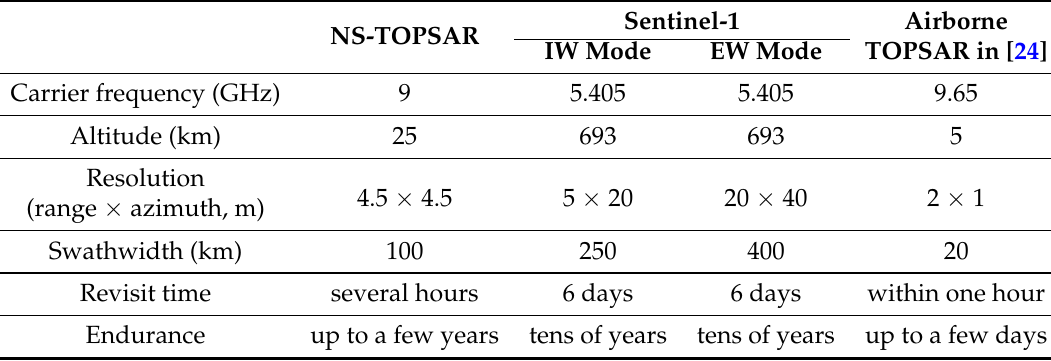
Table 3. Comparison of near-space, spaceborne and airborne